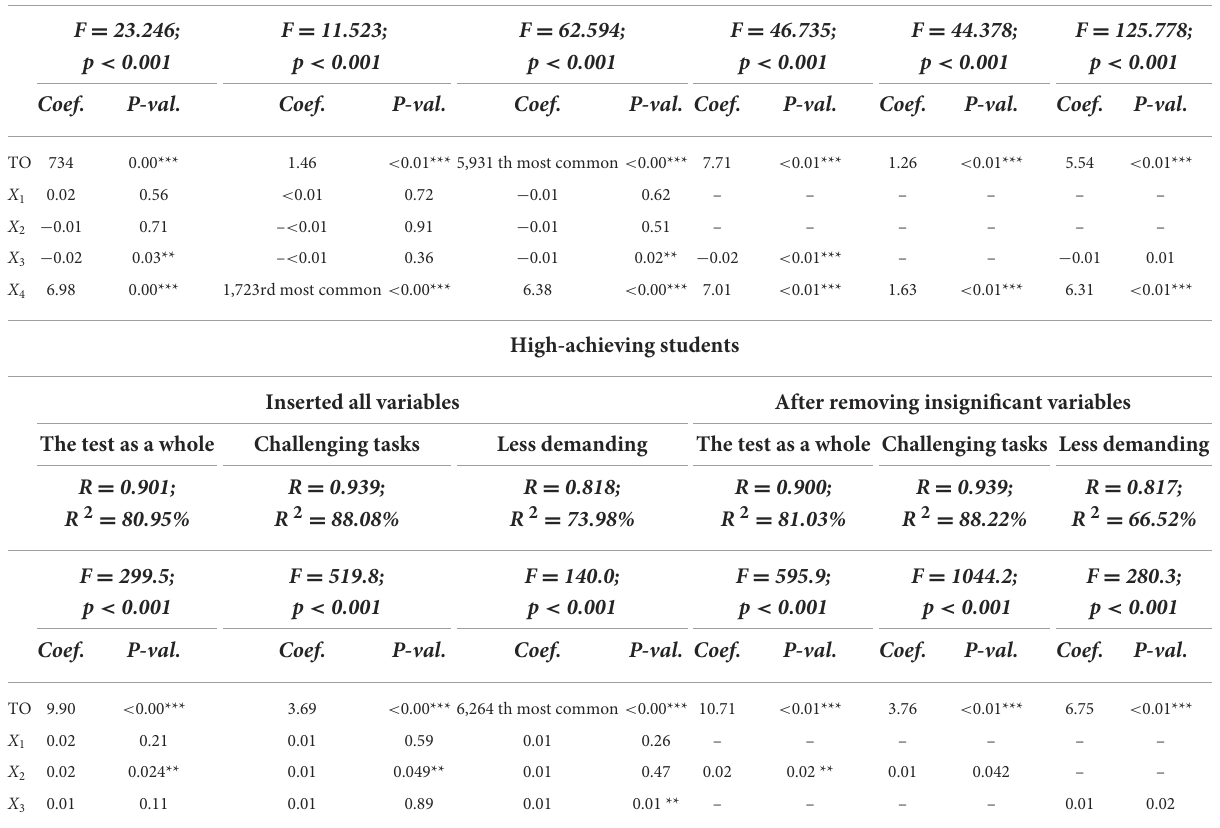
TABLE 4 Regression analysis according to the preferred learning management strategies at different types of schools (all variables). Low-achieving students Inserted all variables After removing insignificant variables The test as a whole Challenging tasks Less demanding